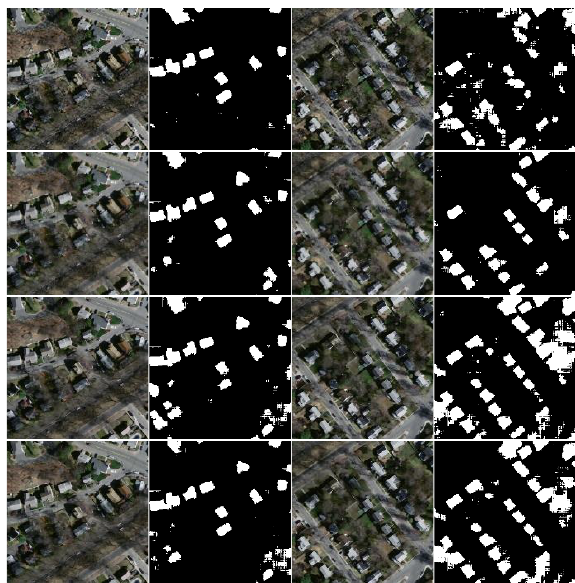
Fig. 5. Examples of the extraction results using “RFANet-